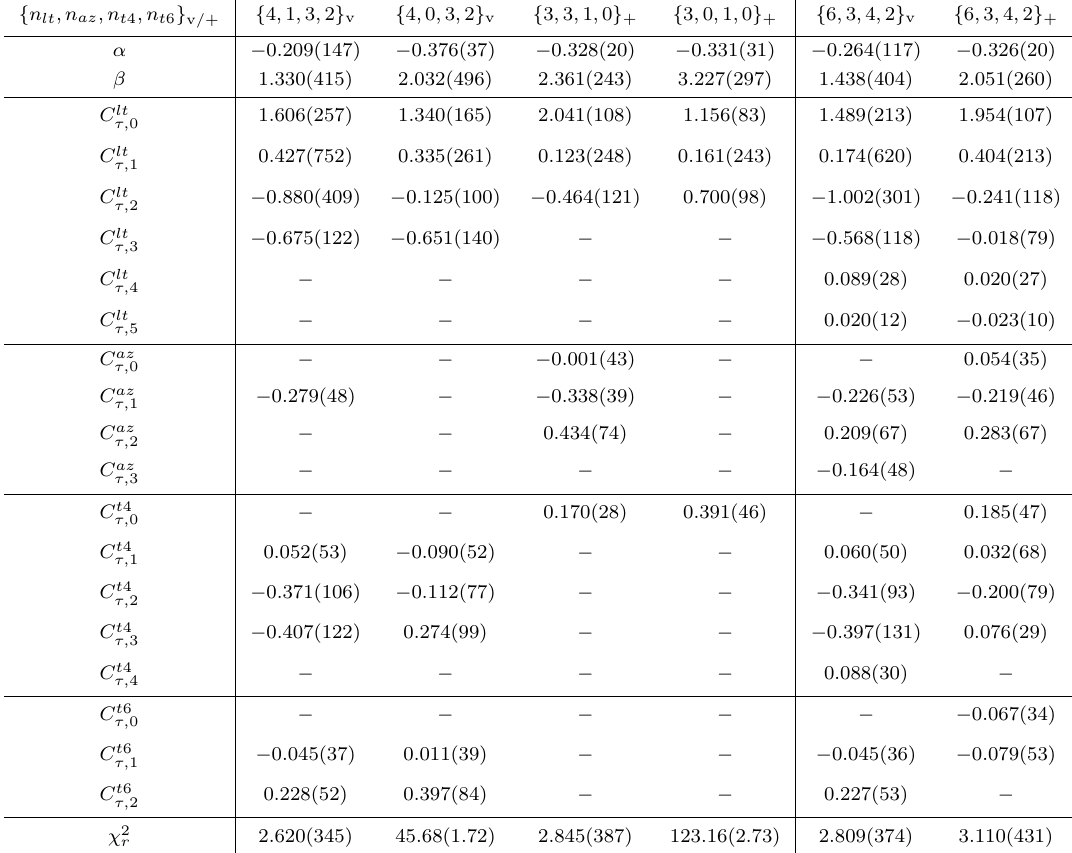
Table 4. Various Jacobi polynomial fits to the real and imaginary components of the unpolarized reduced pseudo-ITD for z/a ≤ 12 . Each column represents distinct orders of truncation in the Jacobi polynomial expansions to the leading-twist, discretization, twist- 4 and twist- 6 corrections. The real and imaginary component fits were found to have the highest likelihoods of describing the data with truncation orders { 4 , 1 , 3 , 2 } and { 3 , 3 , 1 , 0 } , respectively. The dramatic effect even a v + single discretization term has on each fit is shown in the columns { 4 , 0 , 3 , 2 } and { 3 , 0 , 1 , 0 } . v +